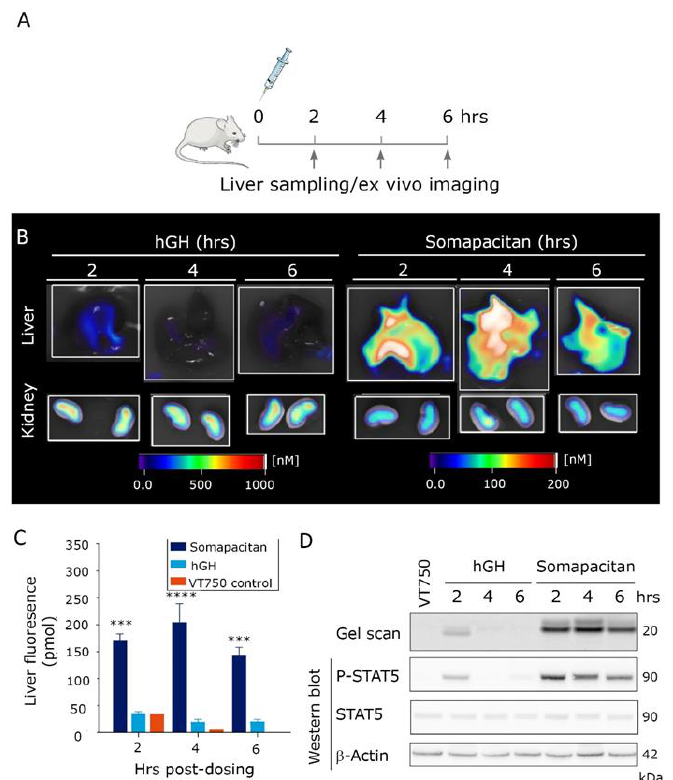
Figure 5. Prolonged residence time and activity of somapacitan in target organs. ( A ) Schematic illustration of ex vivo imaging study design, arrows indicate times for organ harvesting. ( B ) Livers and kidneys of mice dosed GH or somapacitan harvested at 2, 4 and 6 h post-dosing. Fluorescent imaging scale bars are included for reference with scale bars for livers on the right and for kidneys on the left. Highest signals of fluorescence intensities are given in white-reddish (1000 nM for livers and 200 nM for kidneys), lowest intensity depicted in blue (0 nM). ( C ) Temporal quantification of total liver fluorescent intensity (pmol). Somapacitan is shown in dark blue, GH in light blue and VT750 control in orange. Data are shown as mean ± SEM, **** p ≤ 0.0001, *** p ≤ 0.001 depict somapacitan compared with GH ( n = 3 livers per condition). ( D ) Homogenized organs harvested at 2, 4 and 6 h post-dosing, separated on SDS-PAGE. Top lane gel scan acquired at 800 nm, protein size of 20 kDa indicated. Lower bands: Corresponding Western blot of P-STAT5, STAT5 and β -actin loading control. Protein sizes in of 90 and 42 kDa are